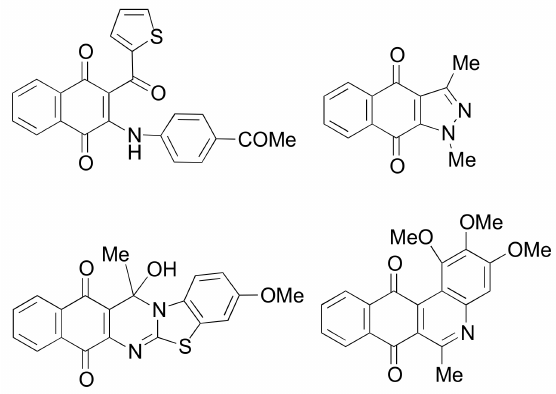
Figure 1. Quinones prepared from acylquinones and nucleophiles.